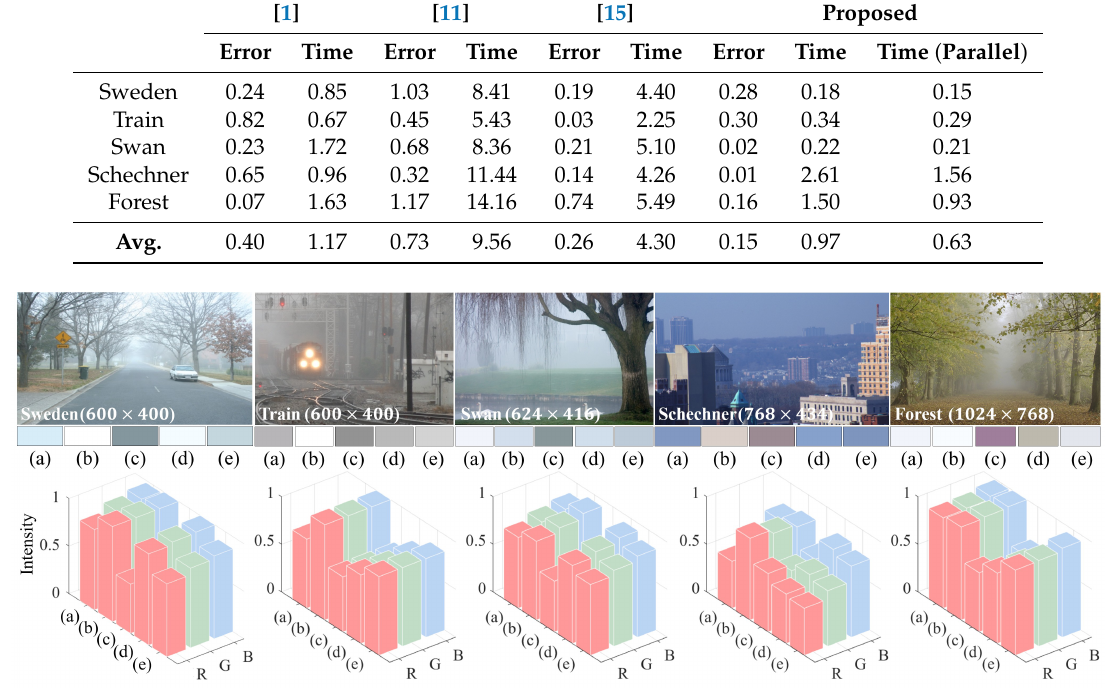
Figure 7. Estimation of the atmospheric light using the proposed and existing methods. The first and second rows respectively show the input haze image and the estimated atmospheric light [20], reproduced with permission from [20], IEEE, 2016. The third row shows the R, G, and B pixel values of estimated atmospheric light: ( a ) ground-truth, ( b ) He’s method [1], ( c ) Sulami’s method [11], ( d )